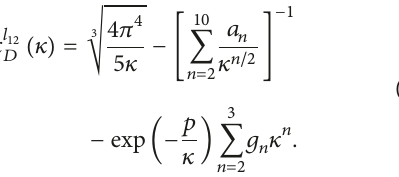
(𝜅) (see (B.8)) 𝑥 ℎ 11 (𝜅) (see 𝐷 𝐷